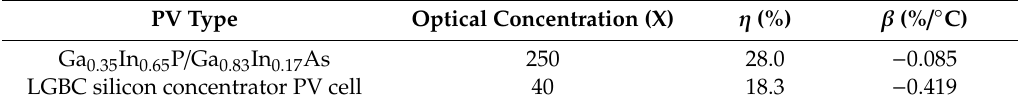
Table 2, including PV e ffi ciency ( η ), e ffi ciency temperature coe ffi cient ( β ), and the optical concentration ratio (X) under which these parameters have been reported. Table 2. Electrical parameters of the selected PV cells. Table 2. Electrical parameters of the selected PV cells Table 2. Electrical parameters of the selected PV cells